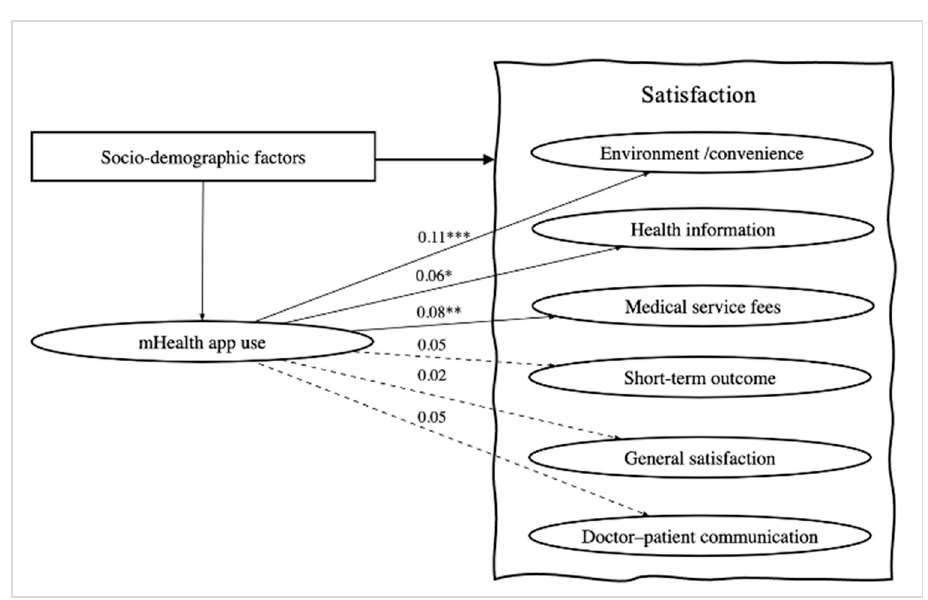
Figure 1. Structural equation model depicting the association of mHealth app use with client satisfaction. Note: Solid lines for significant relationships, dotted lines for non-significant ones; numbers on lines are standardized coefficients from mHealth app use to each domain of satisfaction. *** p < 0.001, ** p < 0.01, and * p < 0.05.